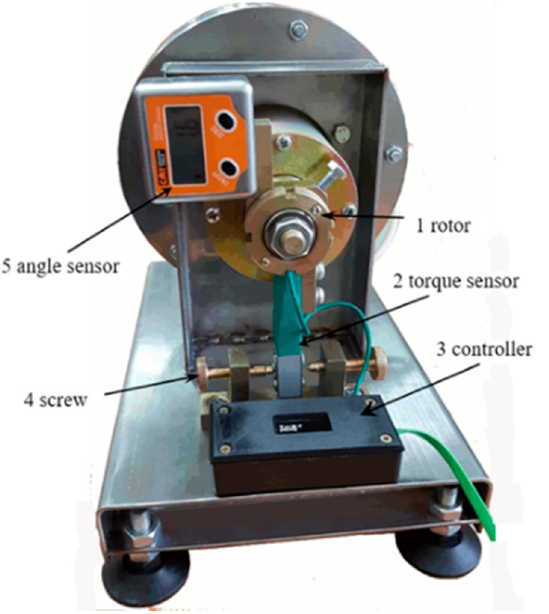
Figure 4. General view of the single-phase prototype of the machine with a measurement system .